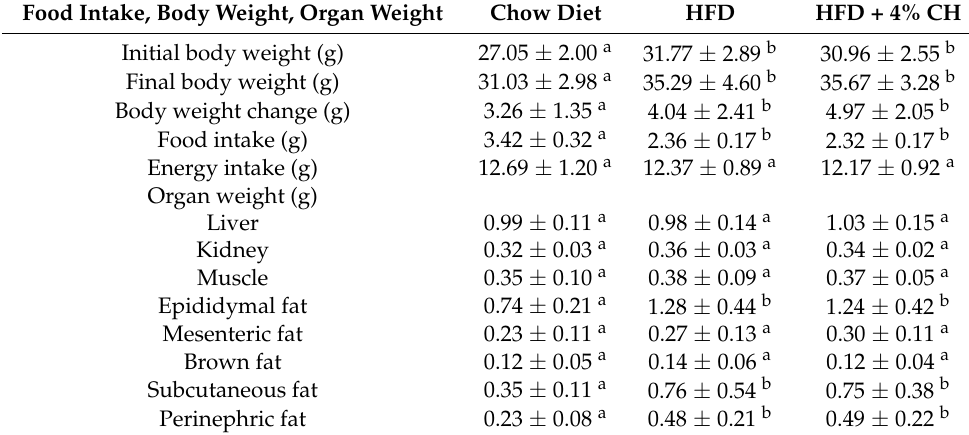
Table 1. The effect of CH on food intake, body weight change, and organ weights in C57BL/6J mice.